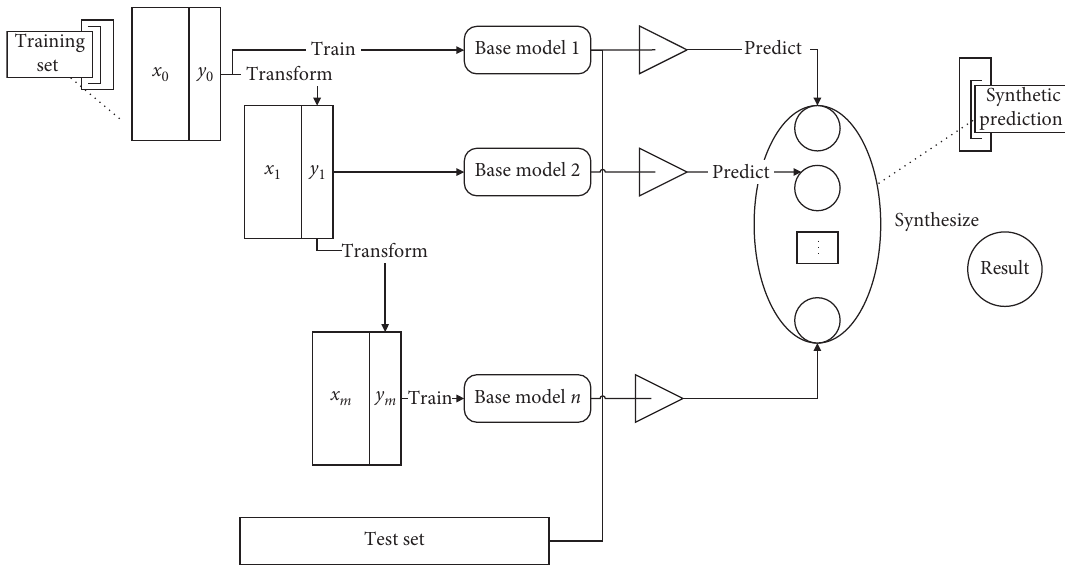
Figure 2: Boosting ensemble learning